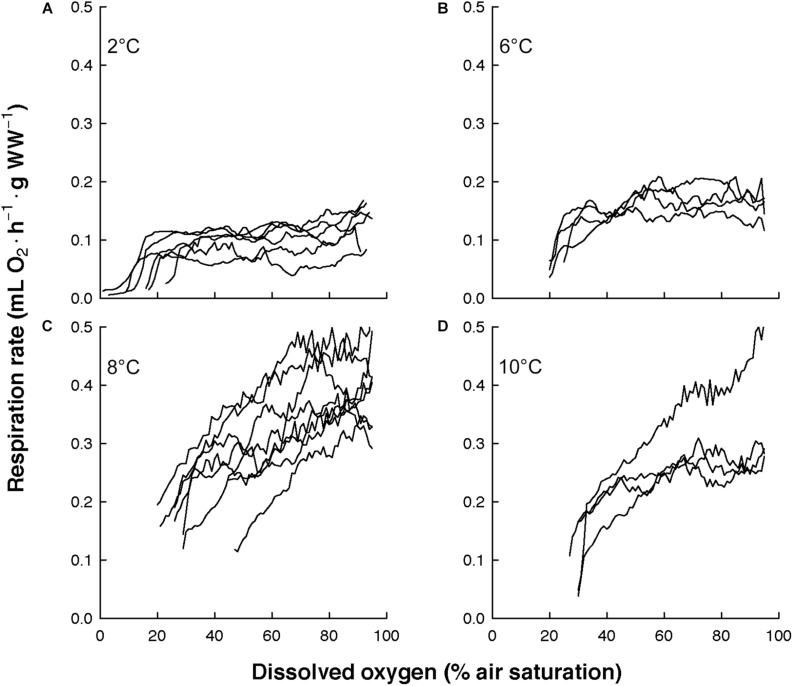
Respiration rates of Thysanoessa inermis over decreasing dissolved oxygen concentration at four temperatures. (A) at 2°C (n = 6), (B) at 6°C (n = 4), (C) at 8°C (n = 8), and (D) at 10°C (n = 4).